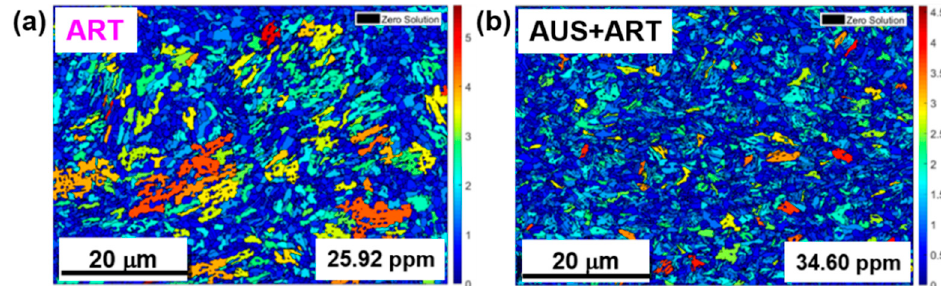
Figure 11. Grain orientation spread figures of ( a ) austenite-reverted-transformation (ART) and ( b ) AUS + ART specimens undergone slow strain rate tensile test after 24-h hydrogen charging.